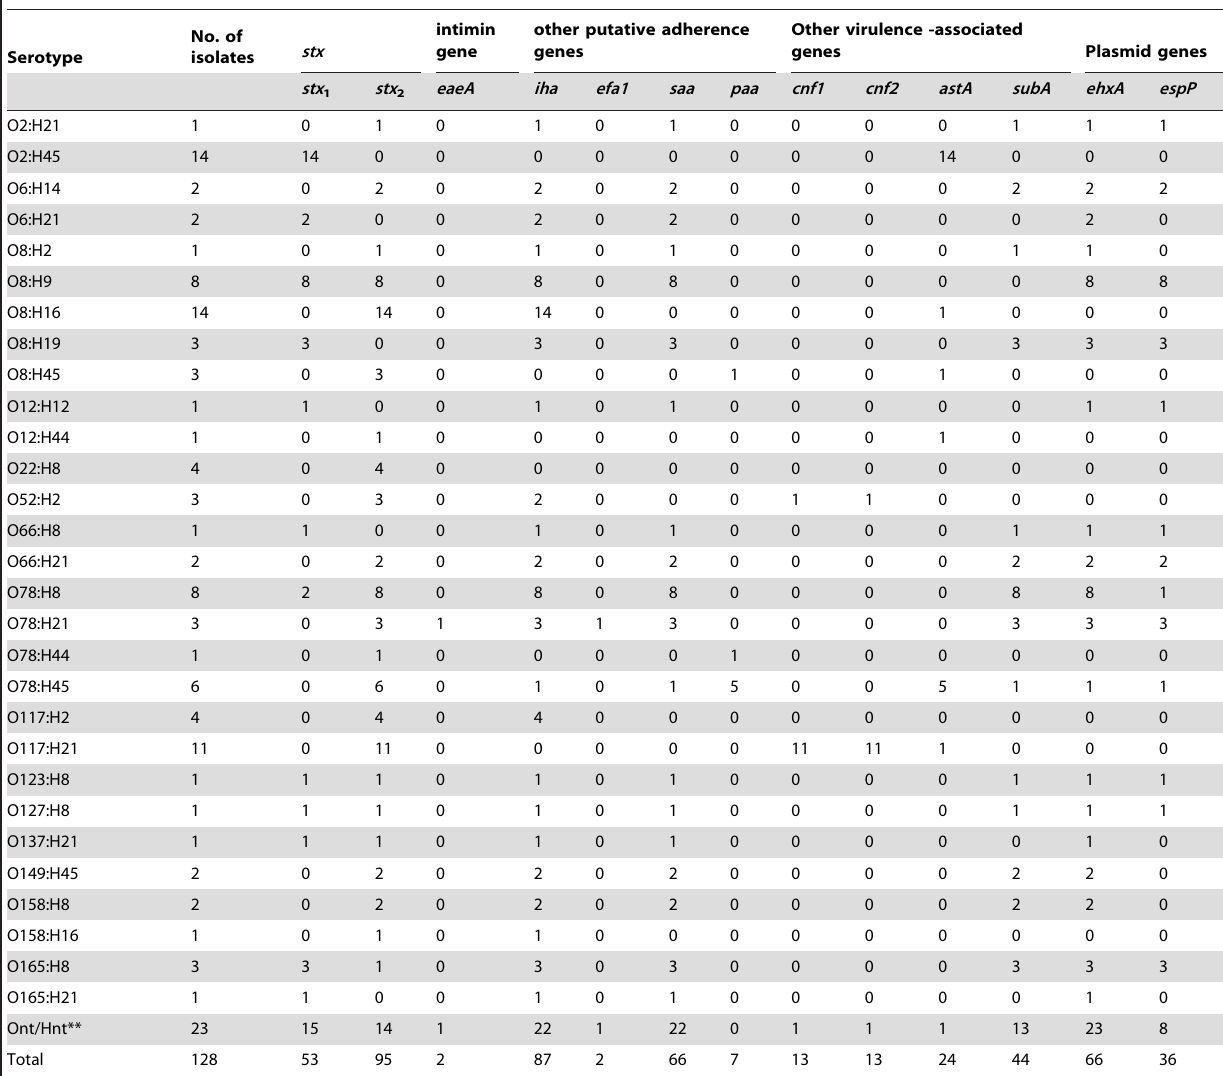
Table 3. Serotypes and virulence factors of Shiga toxin-producing Escherichia coli isolates from yaks*.